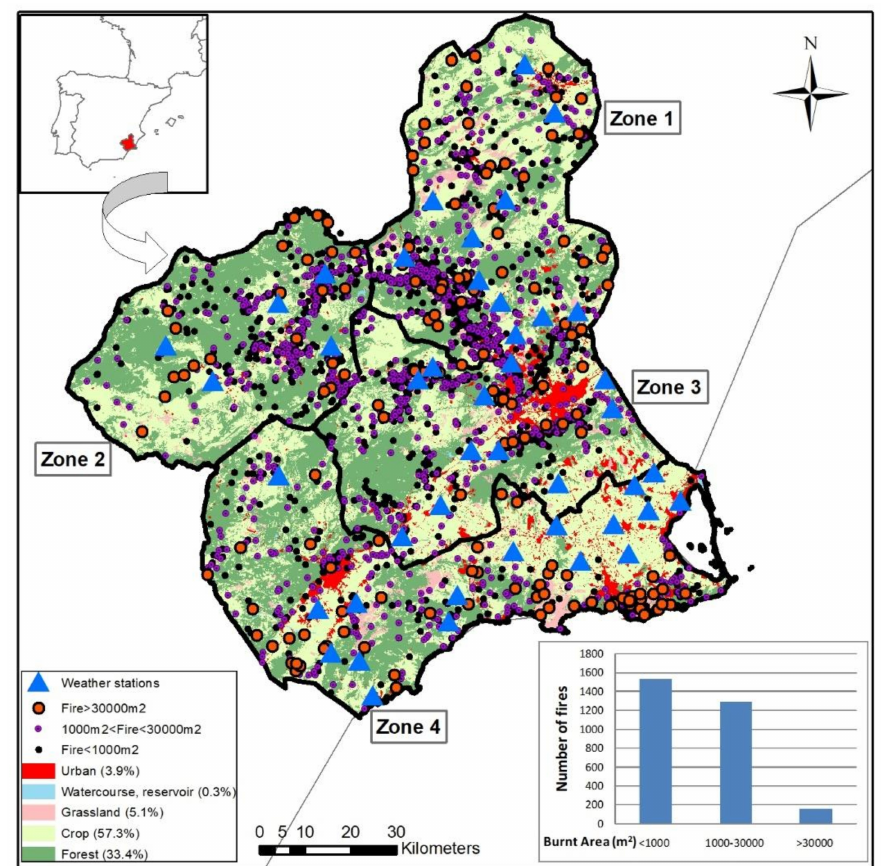
Figure 1. Location of study area, distribution of forest zones, and positions of weather stations and fires according to size of burned area. The histogram shows the relationship between burned area and number of